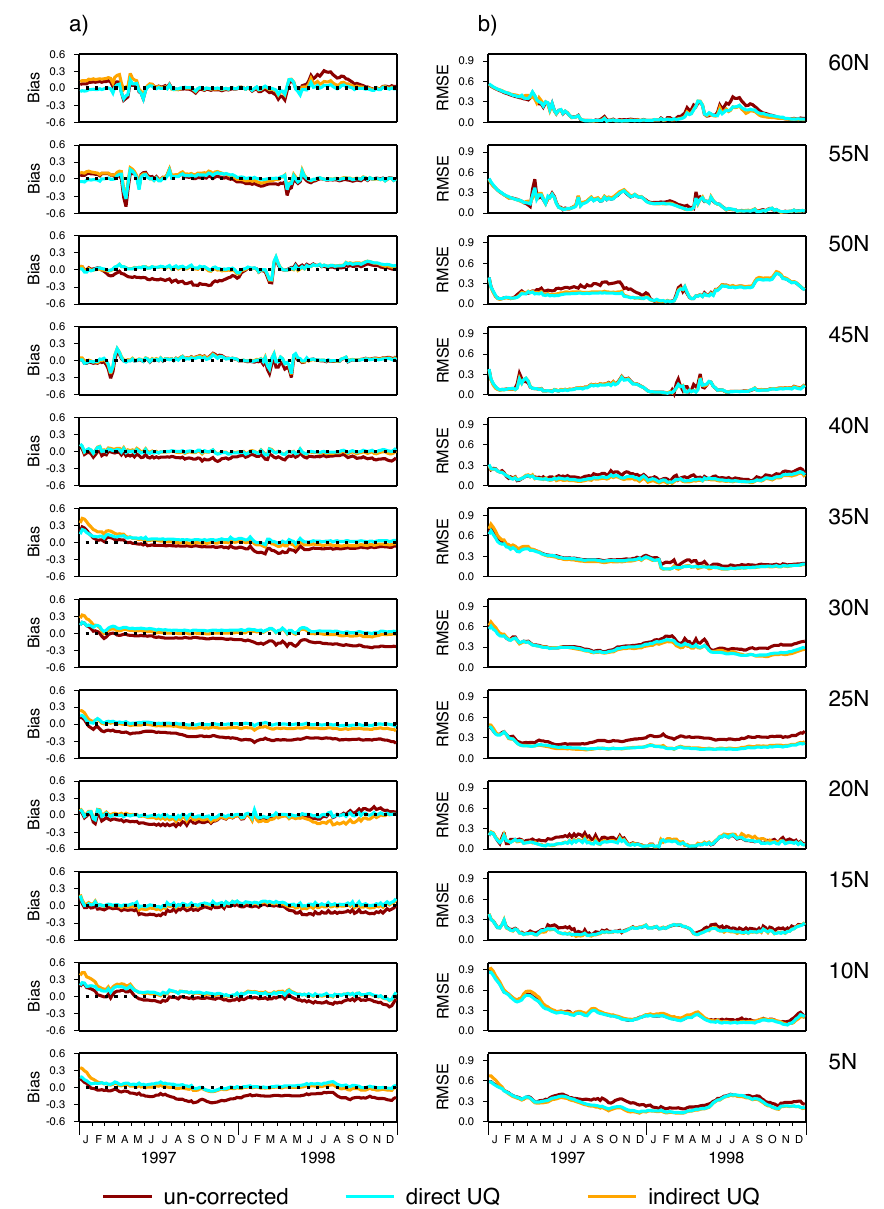
Figure 5. Uninformed emulator error statistics for log 10 (surface chlorophyll) (mgm − 3 ) over 10 experiments, one experiment for each of the parameter vectors in Table 2: (a) bias and (b) rms error. The statistics are shown for the simulators without bias correction and for the bias-corrected simulator array, which is the uninformed emulator. The emulator statistics are given for emulator versions constructed using direct and indirect uncertainty quantification methods (i.e. for errors d Ud and d Ui ).